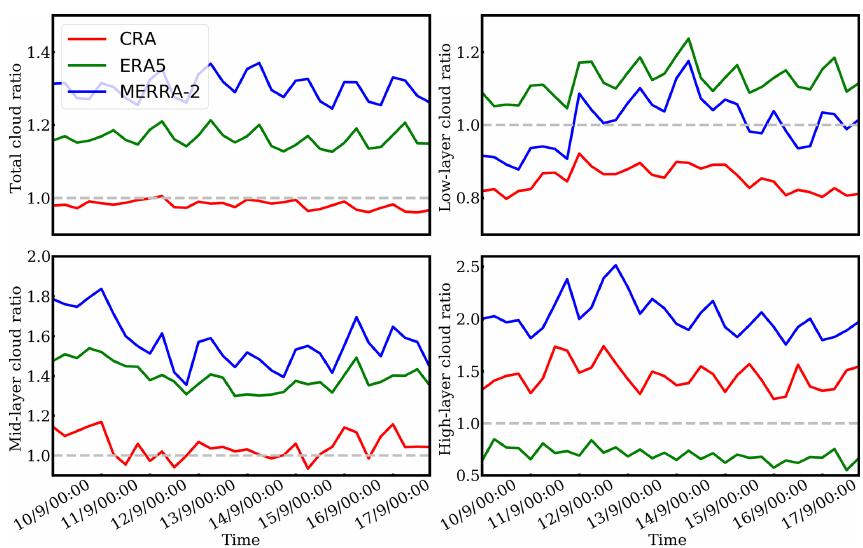
Figure 9. Temporal variation in the ratios (simulation to observation) for different-layer clouds. The classification of clouds is based on the brightness temperature differences of 6.2–11.2µm. The time is labeled as DD/M/time (UTC).